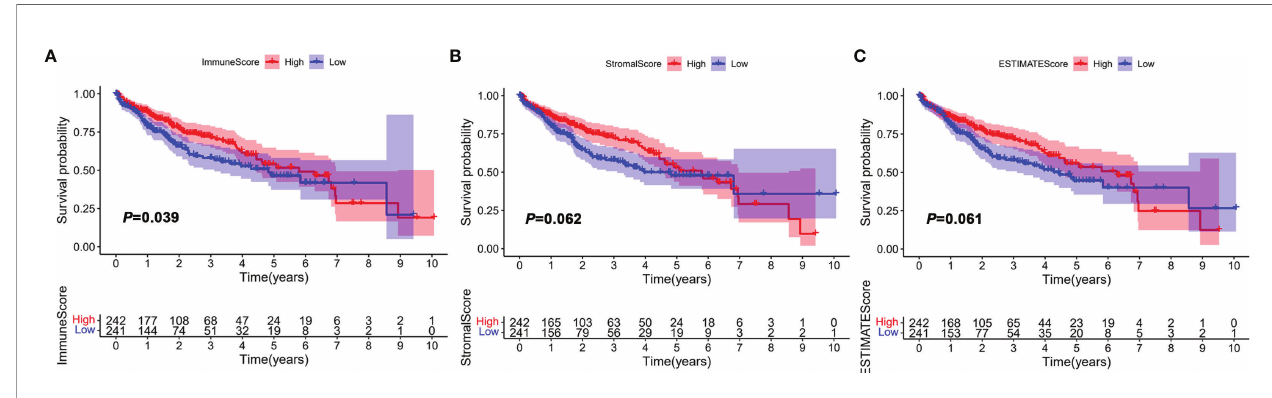
FIGURE 1 | Correlation between ImmuneScore, StromalScore, and ESTIMATEScore with overall survival (OS). HCC patients were divided into two groups according to the median of ImmuneScore, StromalScore, and ESTIMATEScore. High group, n = 242; low group, n = 241. (A) Kaplan – Meier curve analysis of ImmuneScore with the log-rank test; (B) Kaplan – Meier curve analysis of StromalScore with the log-rank test; (C) Kaplan – Meier curve analysis of ESTIMATEScore with the